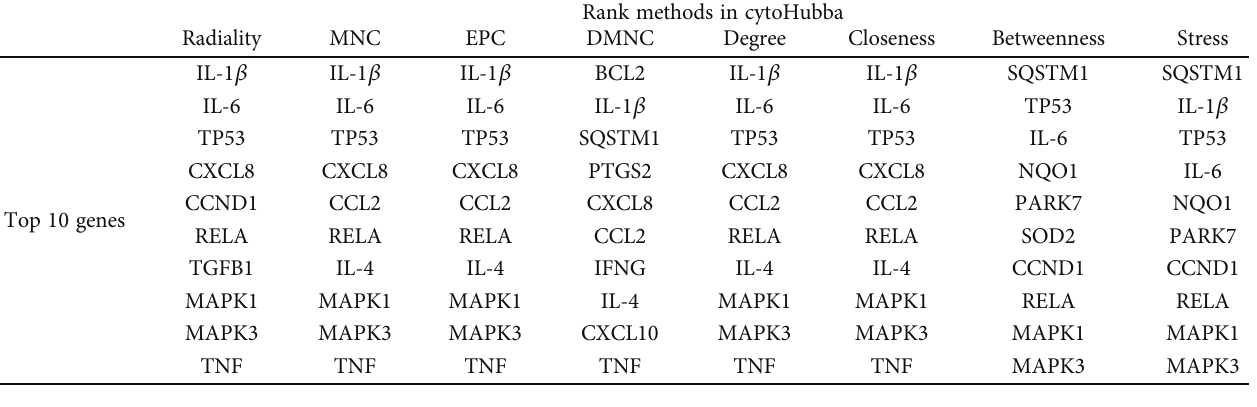
Table 2: The top 10 gene rank in cytoHubba. Rank methods in